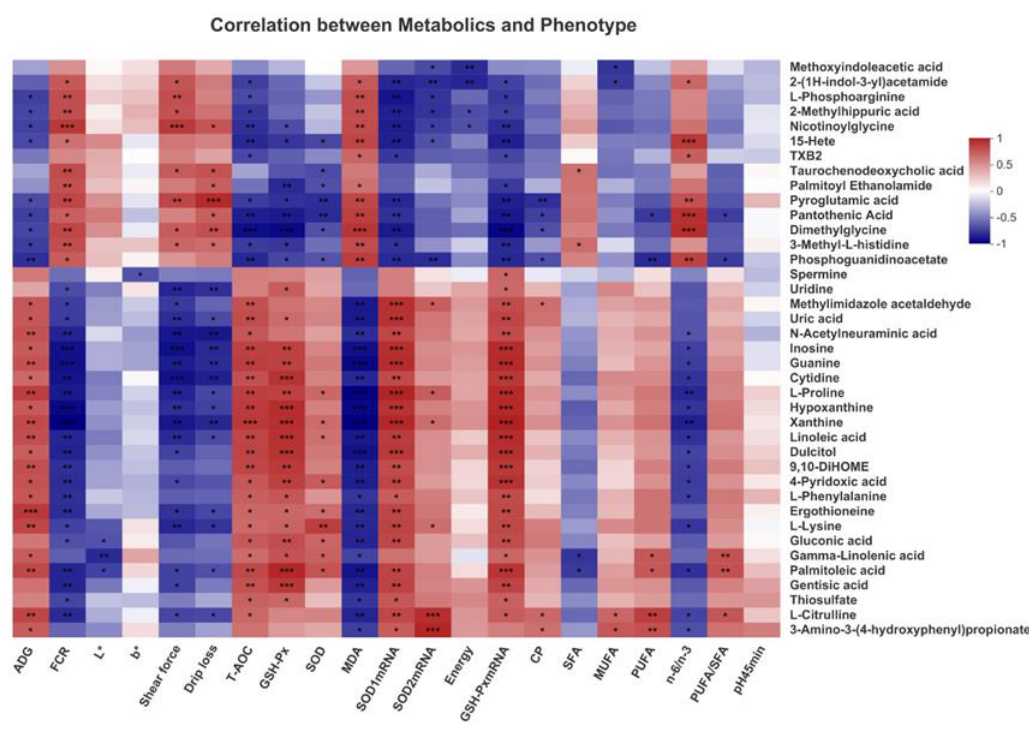
Figure 8. Correlation between the differential serum metabolites and the phenotype of broilers by Pearson correlation analysis. Red indicates positive correlation and blue indicates negative correlation. (* 0.01 < p ≤ 0.05, ** 0.001 < p ≤ 0.01, *** p ≤ 0.001).